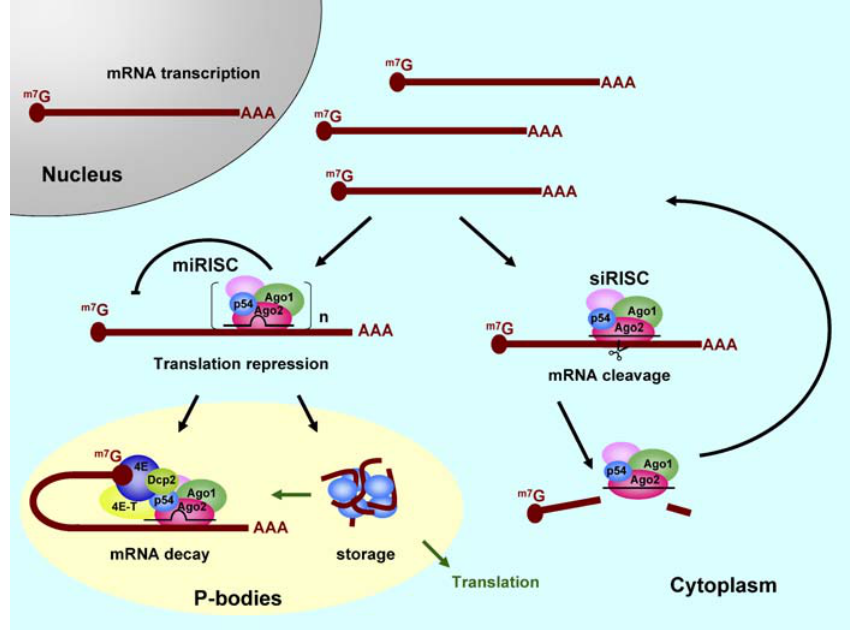
Figure 8. A Model for Human RISC Function Involving miRNA and siRNA RISC contains Ago2 (red), Ago1 (green), RCK/p54 (blue, labeled p54), and other known (e.g., Dicer and TRBP) and unidentified proteins (pink) and is distributed throughout the cytoplasm. siRISC binds to its target mRNA by perfectly matching base pairs, cleaves the target mRNA for degradation, recycles the complex, and does not require P-body structures for its function. Multiple numbers (n) of miRISC bind to target mRNA by forming a bulge sequence in the middle that is not suitable for RNA cleavage, accumulate in P-bodies, and repress translation by exploiting global translational suppressors such as RCK/p54. The translationally repressed mRNA is either stored in P-bodies or enters the mRNA decay pathway for destruction. Depending upon cellular conditions and stimuli, stored mRNA can either re-enter the translation or mRNA decay pathways. DOI: